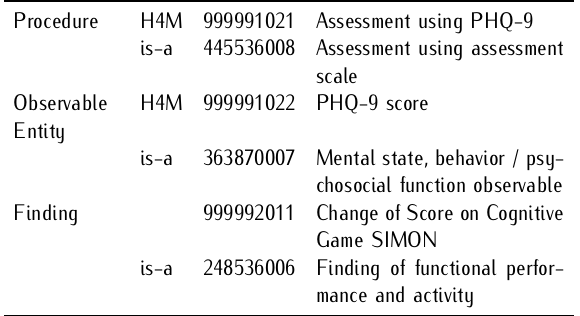
Table 3. Anchoring New Concepts in SNOMED-CT. H4M: Help4Mood concept, is-a: linked SNOMED-CT